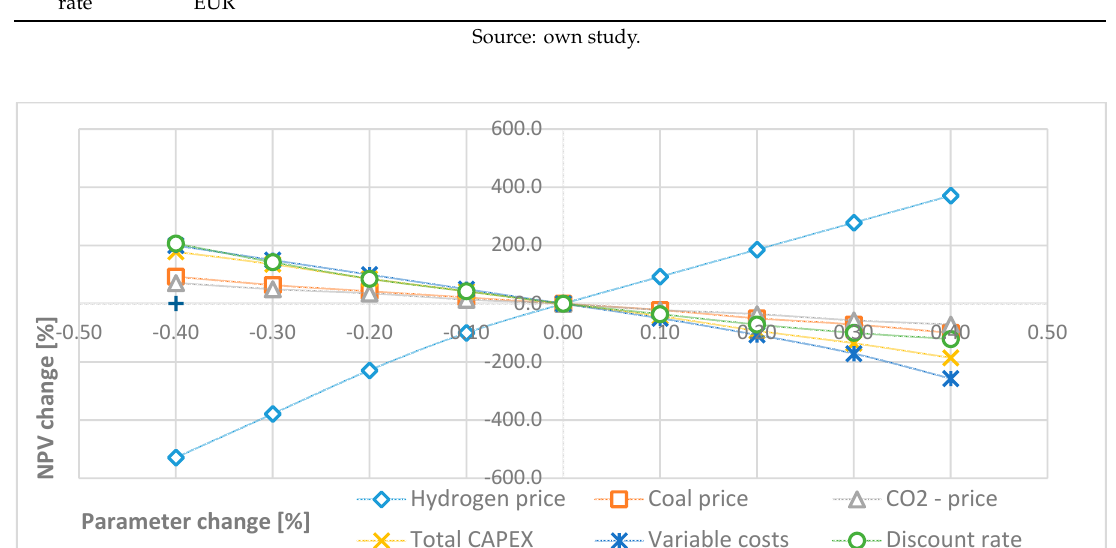
Figure 3. Sensitivity analysis for coal gasification w/o CCS unit (HC_H2_0). Source: own study.